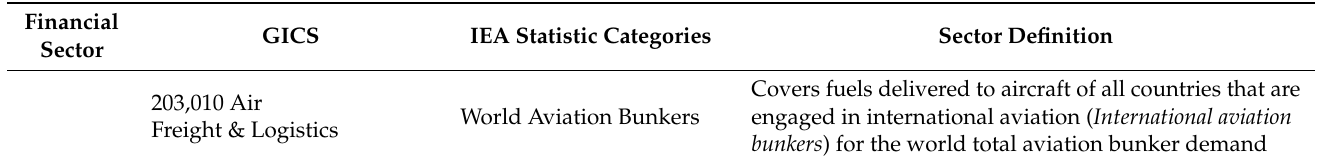
Examples of industry sub-sectors based on the Global Industry Classification Standard